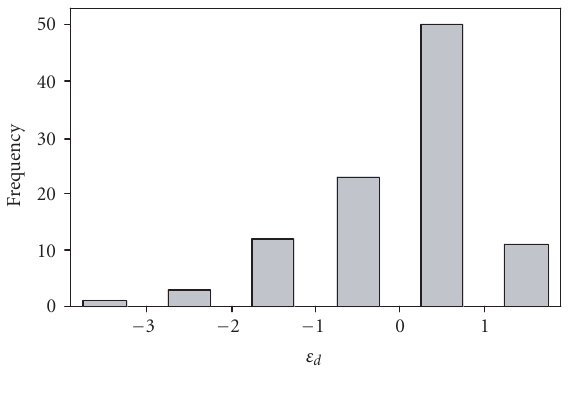
Figure 1: Histogram of ε d distribution.